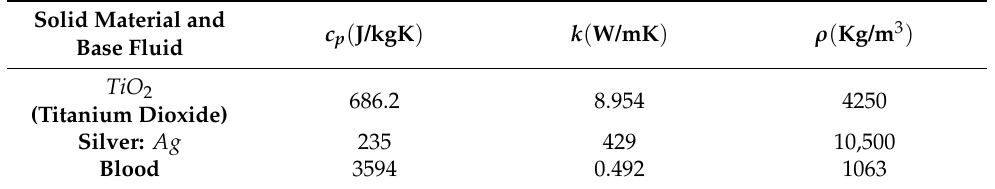
Table 3. Numerous thermophysical properties are defined as [18]. Solid Material